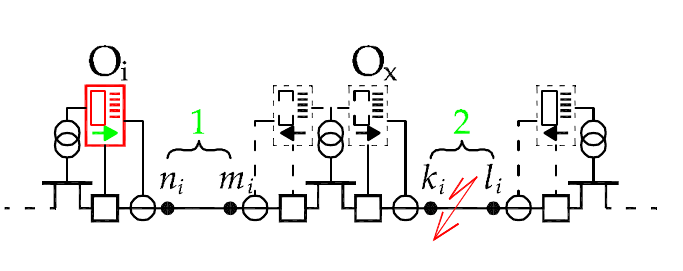
Figure 8. Pickup current choice.